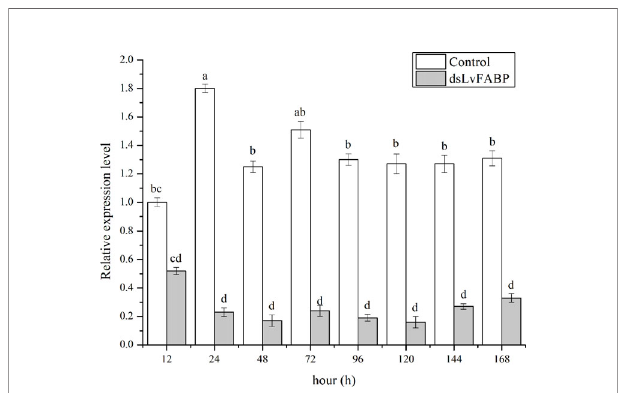
FIGURE 6 | The silencing ef fi ciency at different times of LvFABP . The ds LvFABP , ds EGFP , and NaCl groups (n=10 L. vannamei per group) were established. The experiment period was 2 weeks and dsRNA was injected once every 4 days. Two weeks later, the treated shrimps were tested at 12, 24, 48, 72, 96, 120, 144 and 168 h. Each bar represents the mean ± standard deviation (SD) of triplicate experiments. Different letters indicated signi fi cantly difference (P <